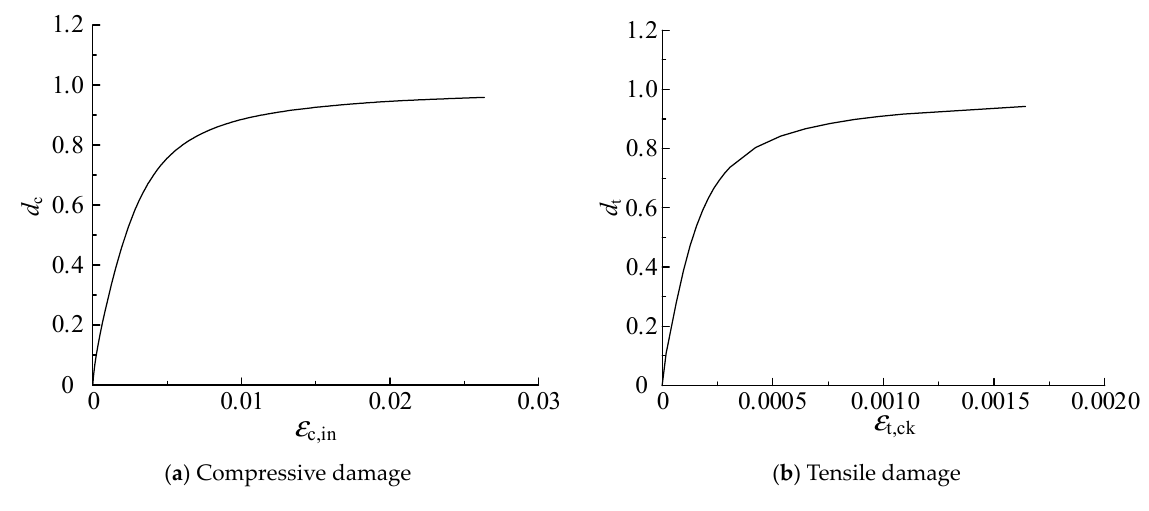
Figure 5. Stress ‒ strain curve of C50 concrete.